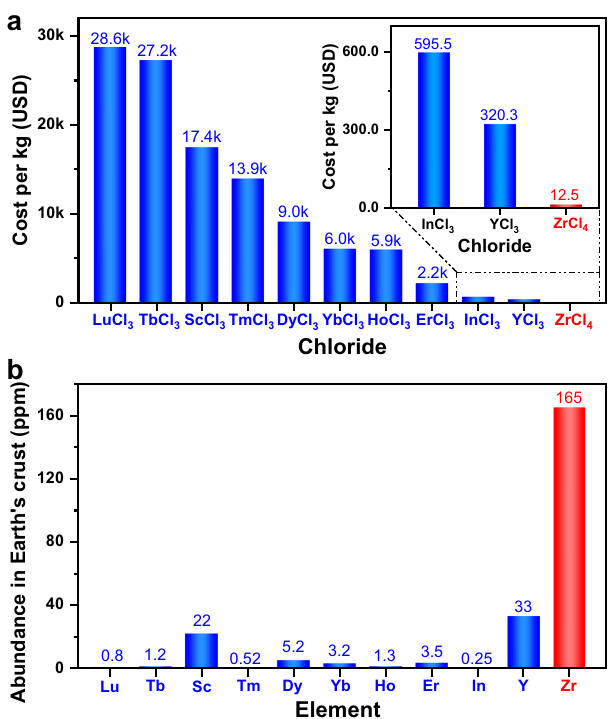
Fig. 1 Raw-material cost of Li 2 ZrCl 6 and the state-of-the-art chloride solid electrolytes. a Estimated unit prices of different chlorides when purchased in the quantity of 1000 kg. These chemicals are the raw materials needed to synthesize different chloride solid electrolytes. The bulk prices plotted here are also listed in Supplementary Table 3, and the laboratory-scale prices used to estimate these bulk prices are provided in Supplementary Table 4. b Abundance of the corresponding non-Li element in Earth ’ s crust 28